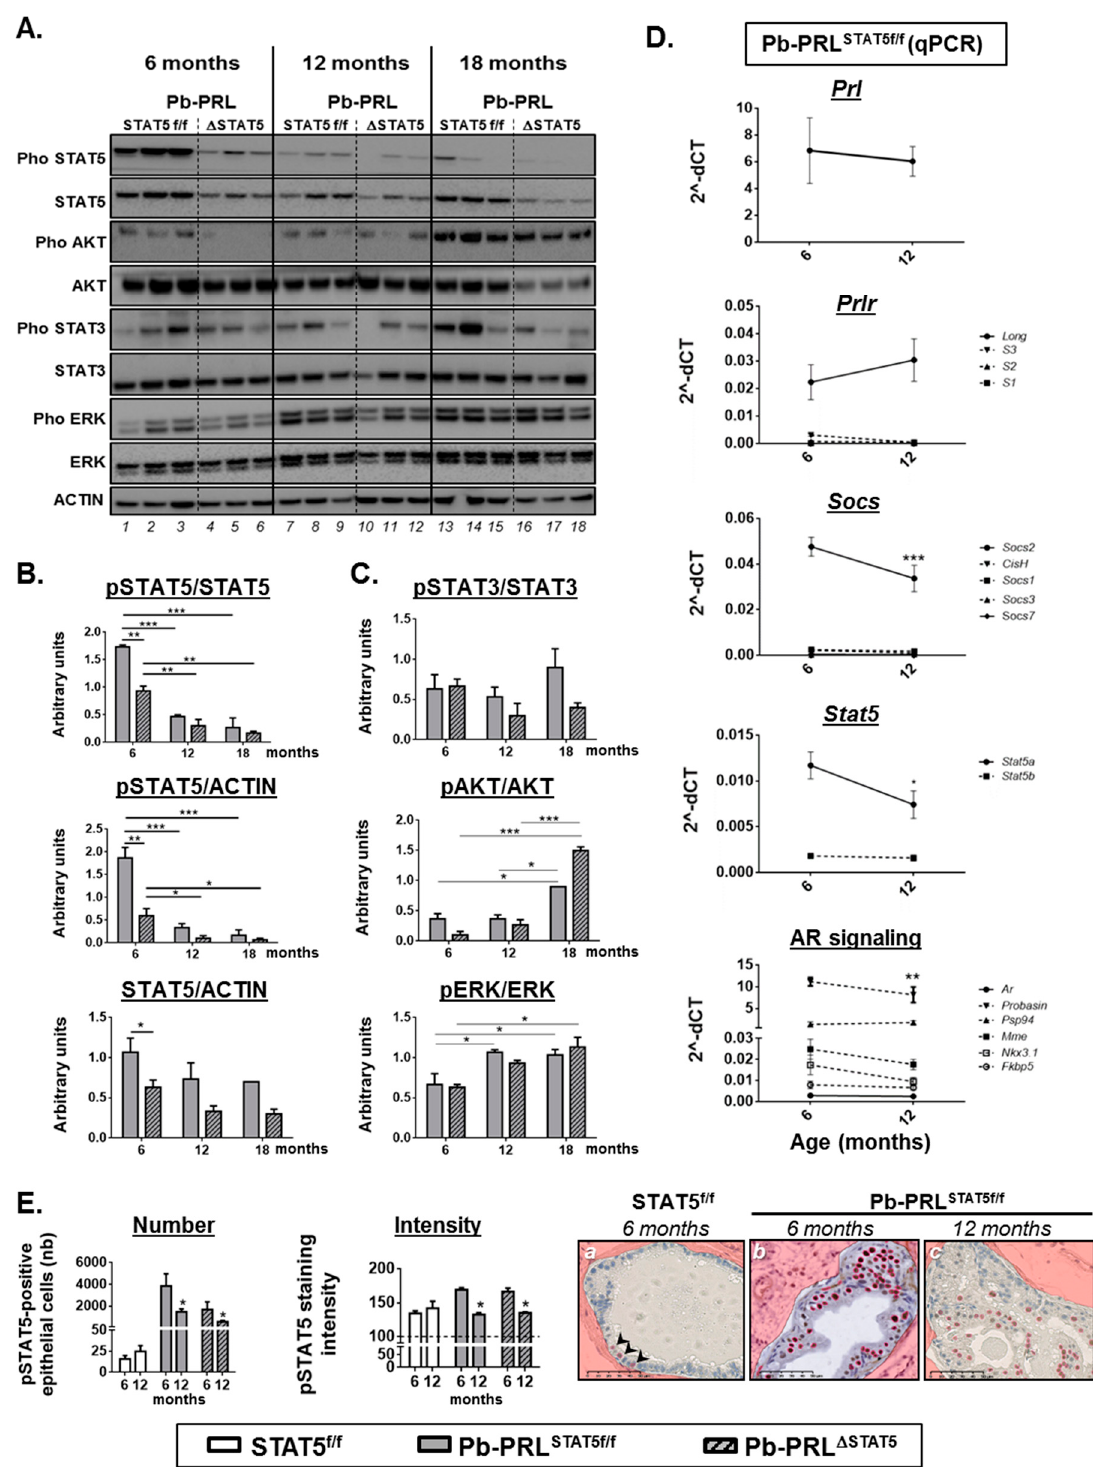
Figure 6. Spontaneous STAT5 signaling shutdown and emergence of AKT and ERK1 / 2 signaling in aged Pb-PRL mice. ( A ). Canonical PRLR signaling pathways activated in dorsal prostates of Pb-PRL STAT5f / f (lanes 1–3, 7–9, 13–15) and Pb-PRL ∆ STAT5 (lanes 4–6, 10–12, 16–18) mice were compared at 6, 12 and 18 months of age as indicated. ( B ). Quantifications of the STAT5 pathway regarding STAT5 activation (pSTAT5 / STAT5 ratio), tissue content in activated (pSTAT5 / ACTIN) and total (STAT5 / ACTIN) STAT5 as determined in panel A. ( C ). The activation of STAT3, AKT and ERK1 / 2 pathways as shown in panel A was quantified by densitometry as the ratio of phosphorylated versus total protein. ( D ). Age-dependent expression of various actors of the PRLR and AR pathways as determined by RT-qPCR in 6